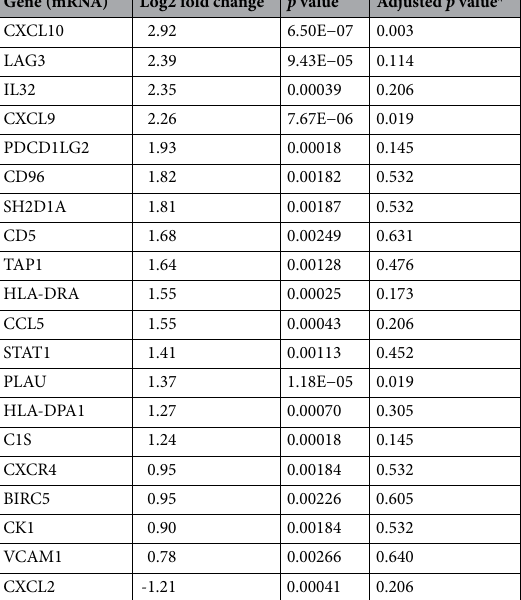
Table 1. List of top 20 genes with a significant fold change between DCIS and invasive carcinoma. * p values were adjusted by Benjamini-Yekutieli